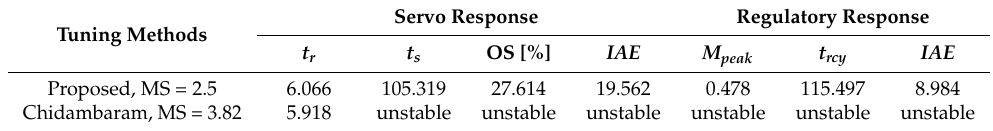
Figure 12. Unit step responses and control inputs for 20.5% uncertainty process 𝑃 3 . ( a ) Unit step responses; ( b ) control inputs. Table 13. Performance comparisons for 20.5% uncertainty process 𝑃 3 .